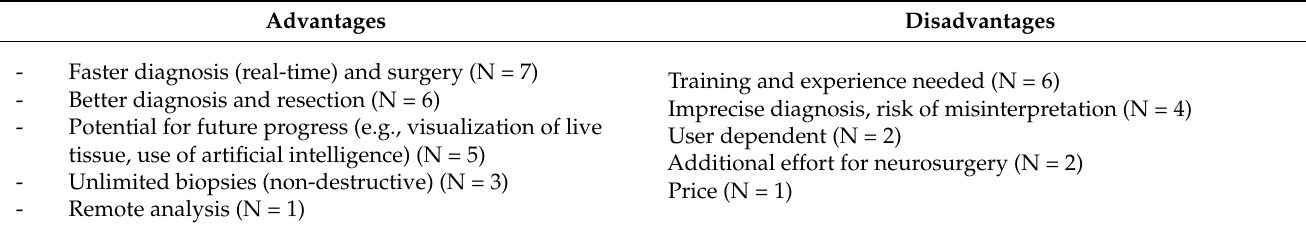
Table 4. Advantages and disadvantages of CLE according to the survey participants